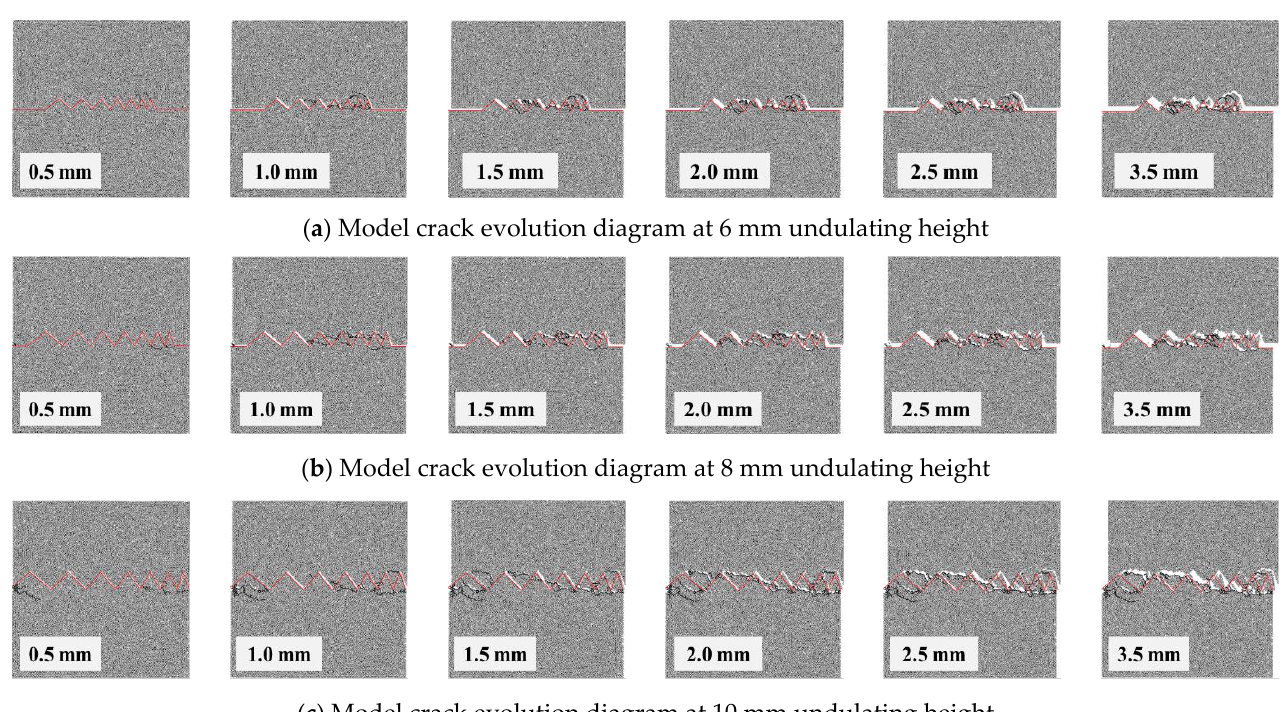
Figure 16. Model crack evolution under different undulating heights.